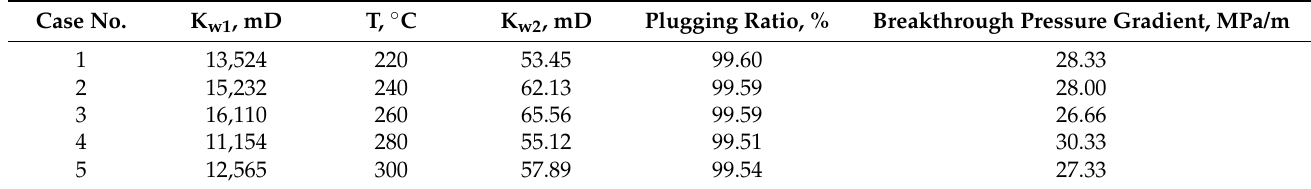
Table 3. High-temperature plugging results for sandpacks with different permeability.